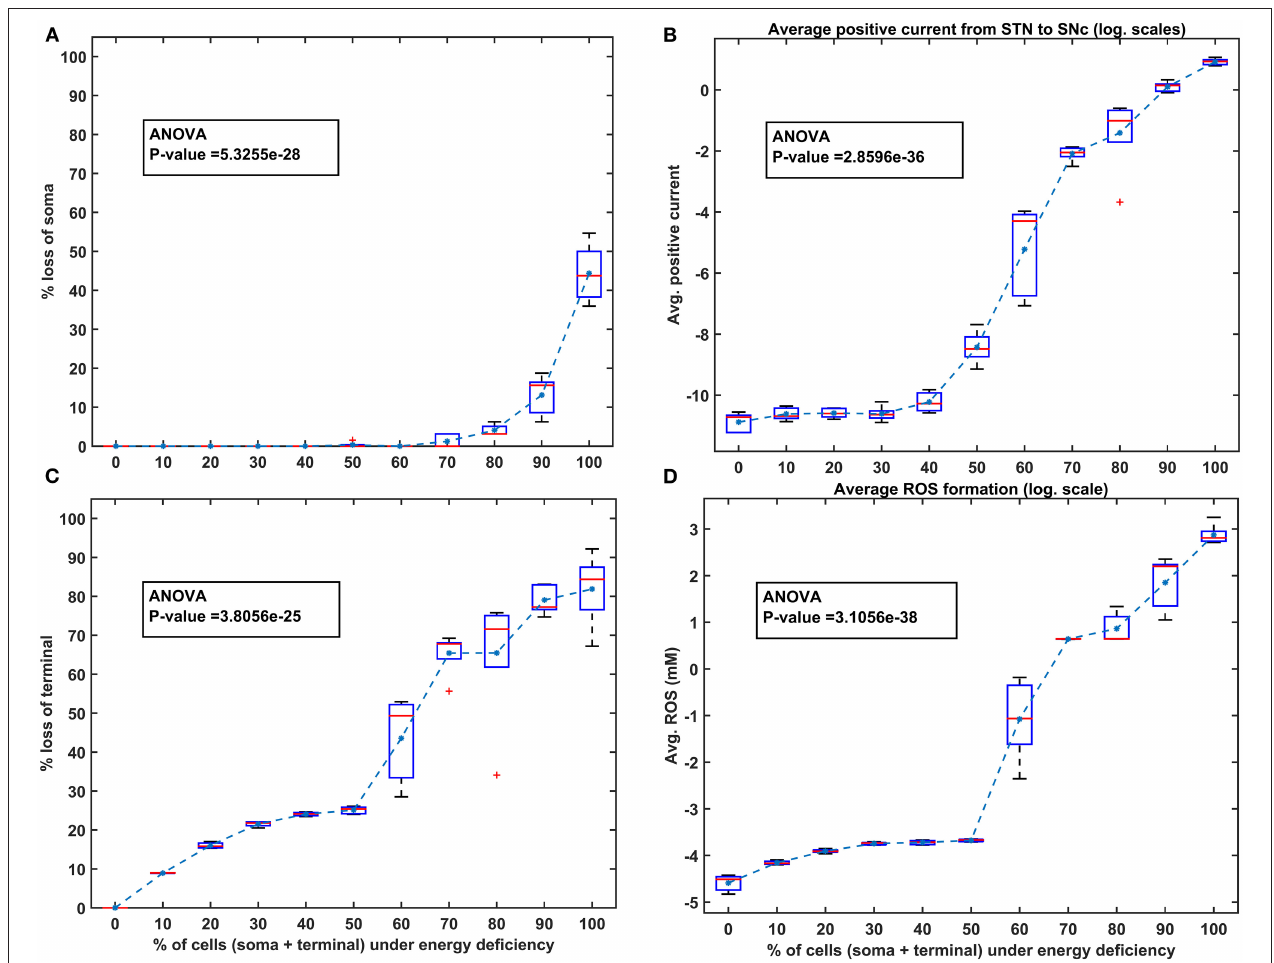
FIGURE 5 | The model response under homogeneous energy deficiency. (A) The percentage loss of SNc somas, (B) the average positive current (log. scale) from STN to SNc, (C) the percentage loss of SNc terminals, (D) the average ROS concentration (log. scale). STN, subthalamic nucleus; SNc, substantia nigra pars compacta; ROS, reactive oxygen species; mM,